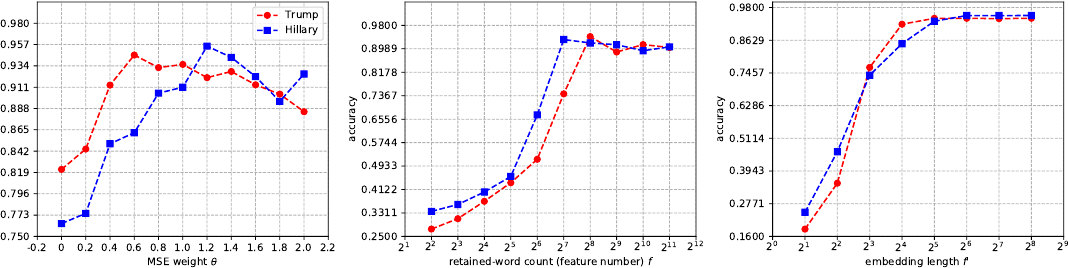
Figure 7. Results of the parameter rotation experiment. Red curves refers to experiments regard the sentiment towards Donald Trump, and blue curves regard to Hillary Clinton. All three sub-figures share the same legend.